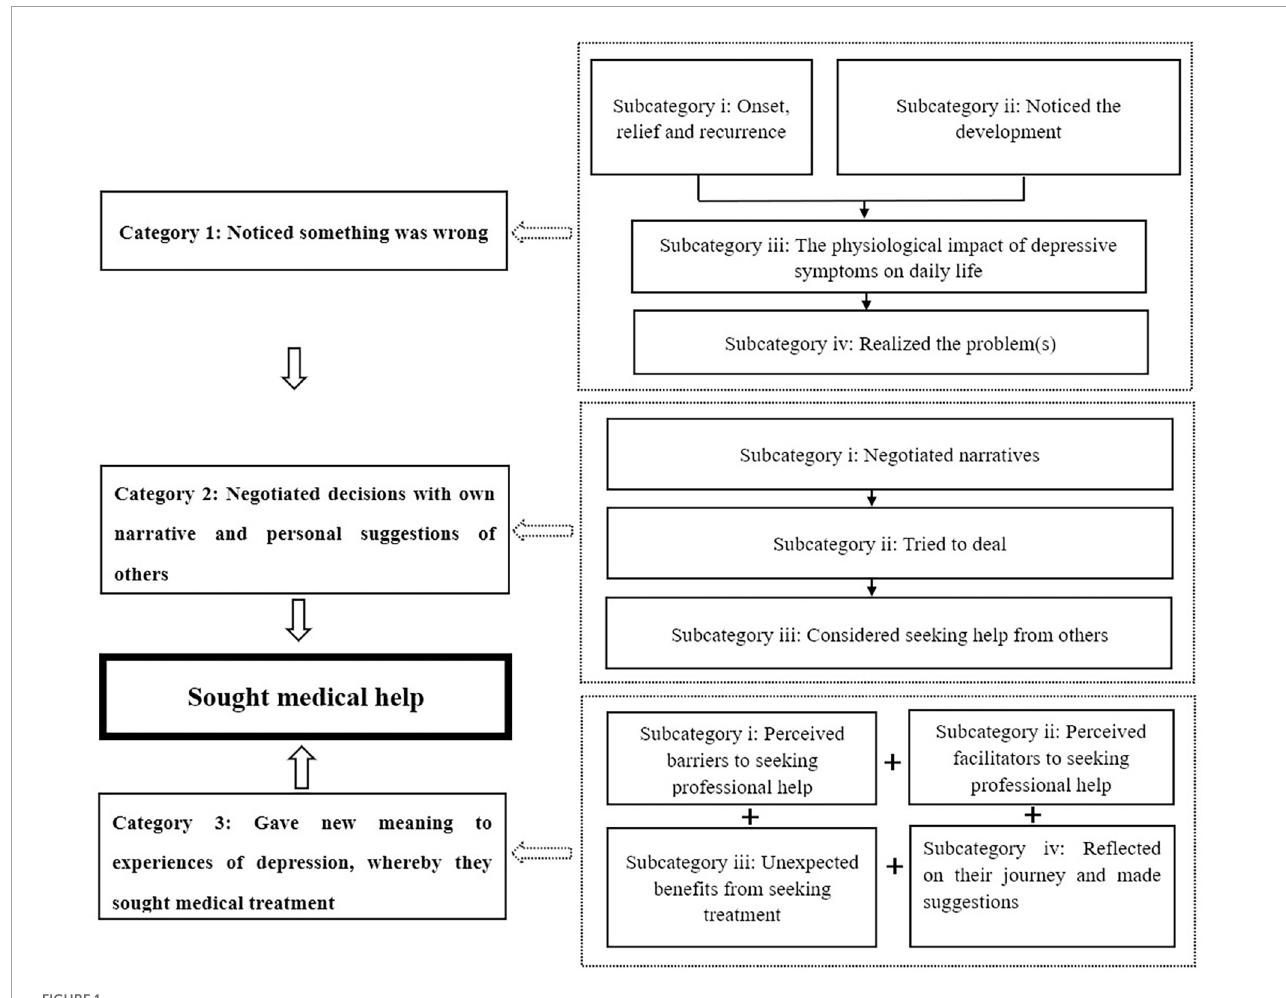
FIGURE1 The road map of the persons’ decision-making